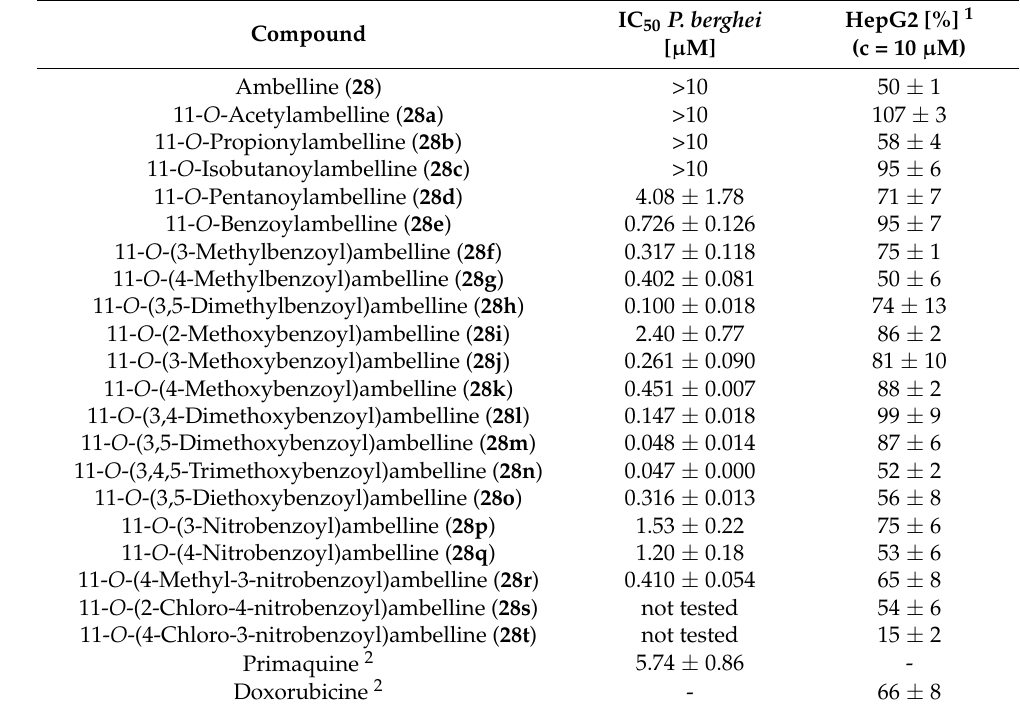
Table 1. Activity of ambelline derivatives against the hepatic stage of malaria caused by P. berghei and their cytotoxic potential.